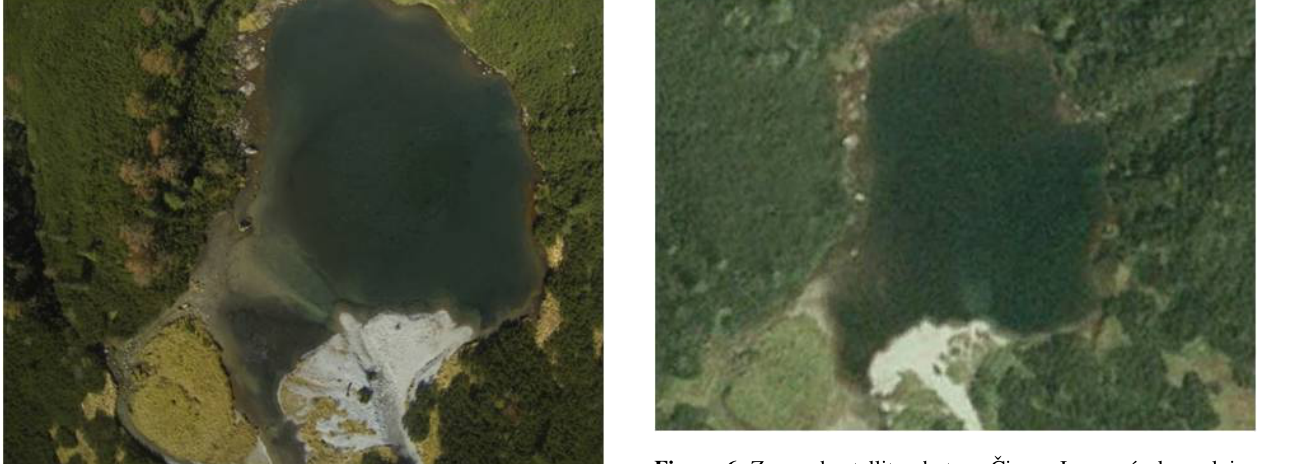
Figure 6. Zoomed satellite photo – ˇCierne Javorové pleso alpine lake (Google Earth,